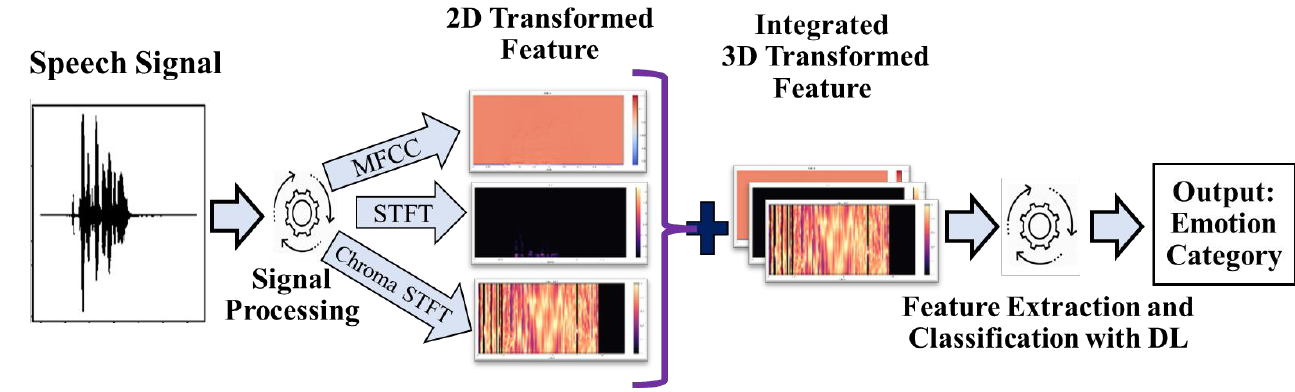
Figure 2. General architecture of proposed REIS approach.